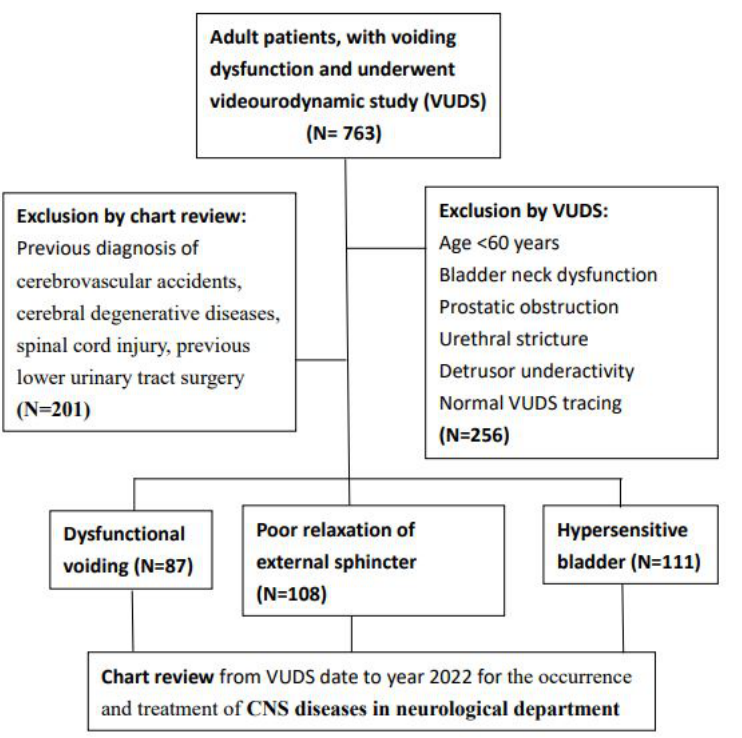
Figure 1. The patient selection flow chart.